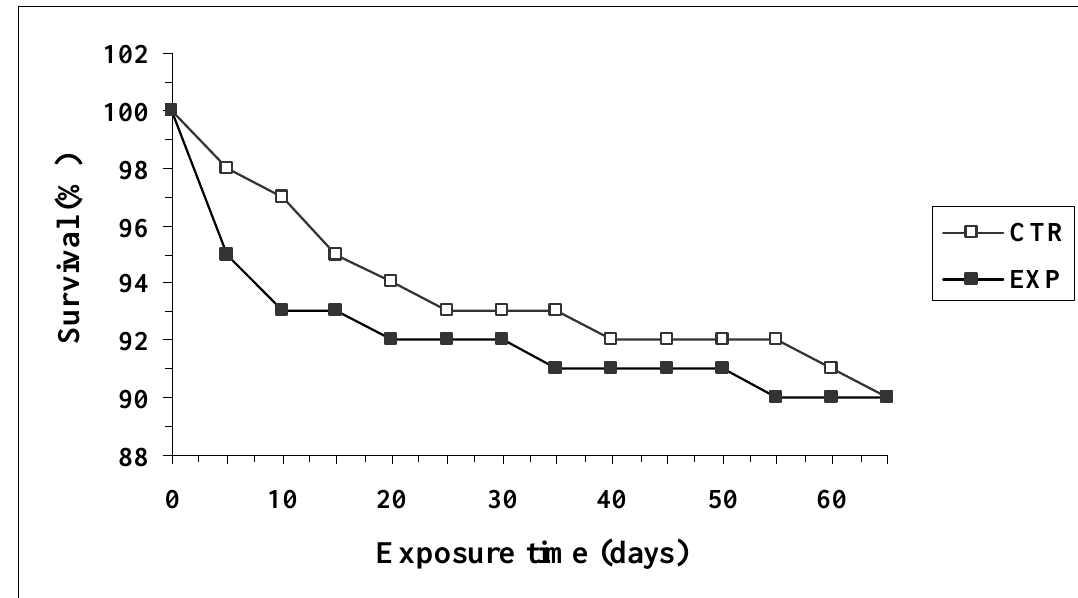
FIGURE 1 . MF dependence of tadpole survival rate. (o) Control population made by unirradiated individuals maintained for 65 days outside the SLD; ( • ) experimental population made by individuals maintained for 65 days inside the SLD. The points represent the mean of four sets of experiments.